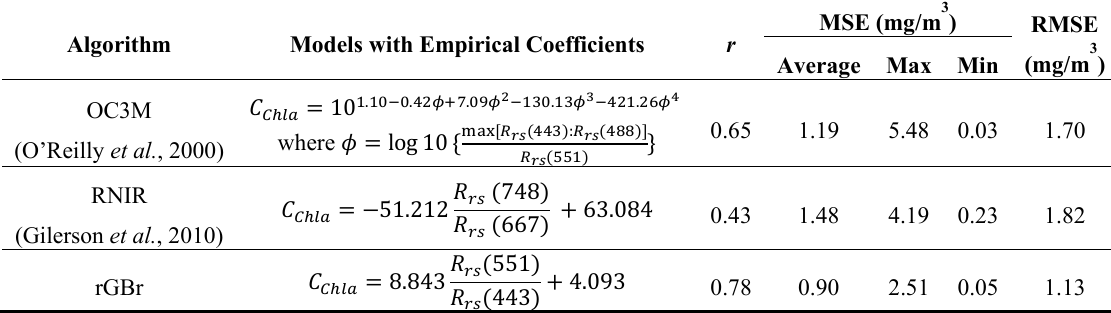
Table 3. Comparison of three algorithms for estimating the accuracy of Chl-a concentrations. The accuracy is evaluated by the linear correlation coefficient ( r ), mean square error (MSE) and root mean square error (RMSE) for the 40 sample values. RNIR, red-near-infrared band ratio algorithm